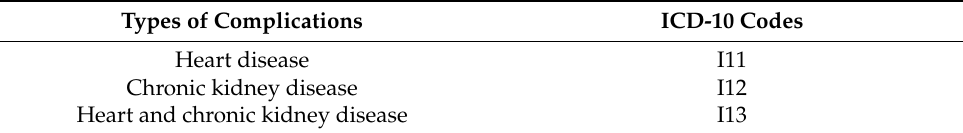
Table 2. Types and ICD-10 codes of hypertension complications.